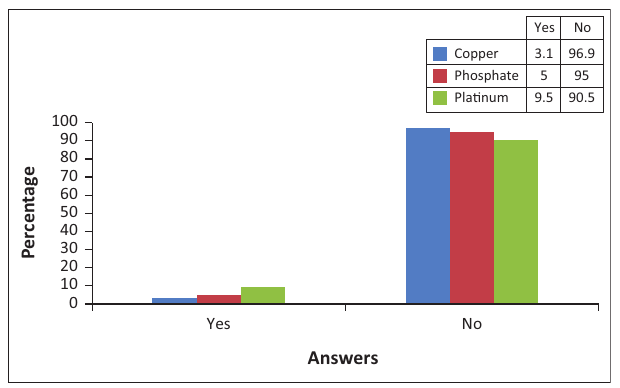
FIGURE 1: Have you ever been approached for sex in the workplace in exchange for